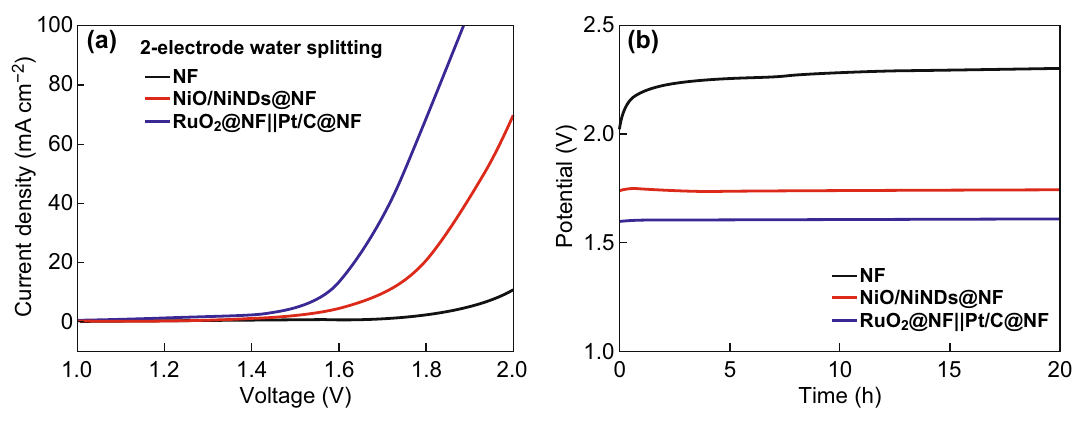
Fig. 4 a Overall water‑splitting characteristics of different catalyst electrodes in a two‑electrode configuration. b Chronopotentiometric curves of water electrolysis for different catalyst electrodes in a two‑electrode configuration with a constant current density of 13 mA cm −2 (without iR